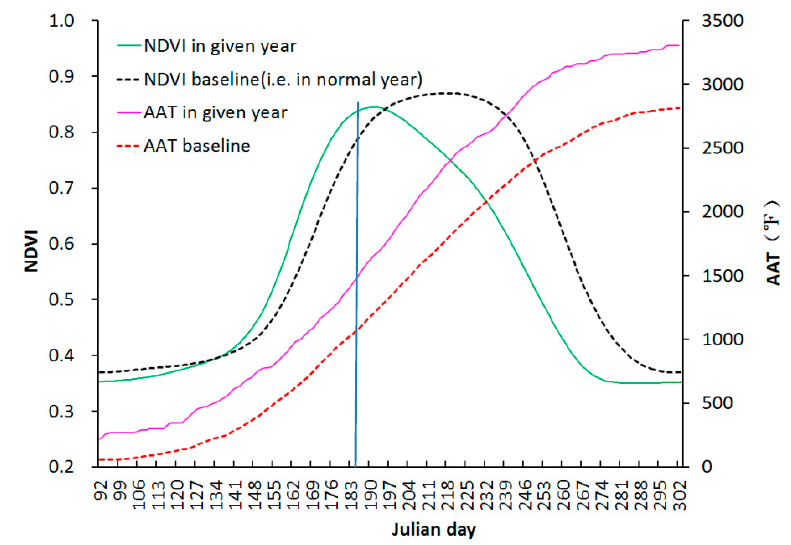
Figure 7. Corn NDVI curve (corn phenology) and AAT curve covering the growing season of 2012 (a given study year) are compared with the baseline based on the same Julian calendar day. The green solid and black dashed lines are 2012 NDVI curve and NDVI baseline, respectively. The pink solid and red dashed lines are 2012 AAT curve and AAT baseline. Compared with the NDVI baseline, the 2012 corn phenology is significantly earlier than baseline (the entire NDVI curve appears left of the baseline). The 2012 AAT curve is above the ATT baseline, which means 2012 crop reaches the same growth stages earlier.